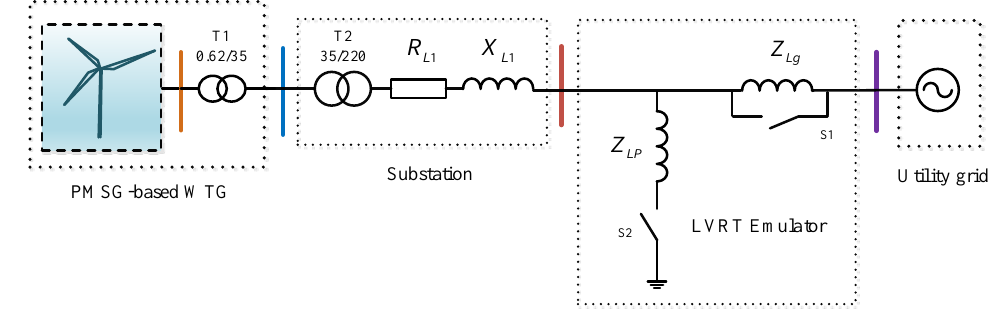
Figure 9. Layout of the test WTG system and the grid fault emulator.